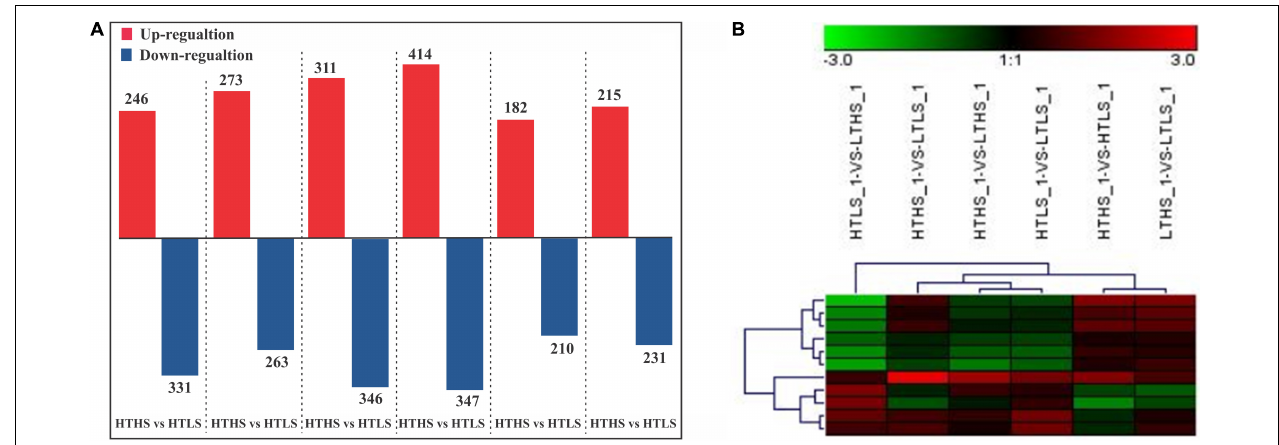
FIGURE 2 | (A) Bar plot of differentially expressed protein in each pairwise comparison and (B) the differently expressed proteins (down- and up-regulation). X -axis, names of the comparison groups; Y -axis, the number of the differentially expressed protein. Red column, up-regulation protein; Green column, down-regulation